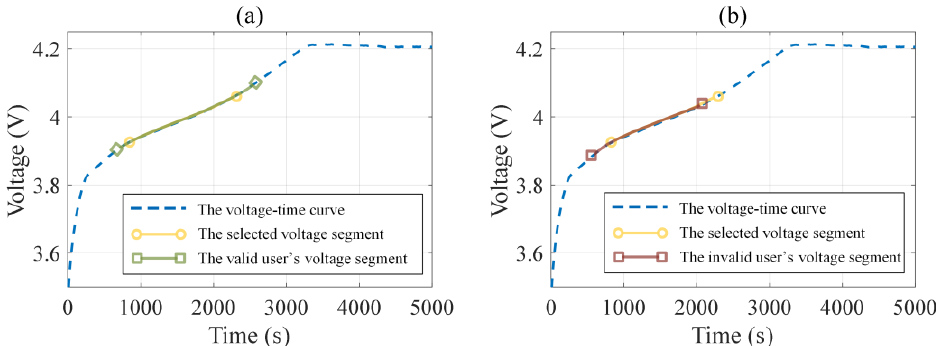
Figure 1. Incomplete charging processes: ( a ) a valid voltage segment; ( b ) an invalid voltage segment.